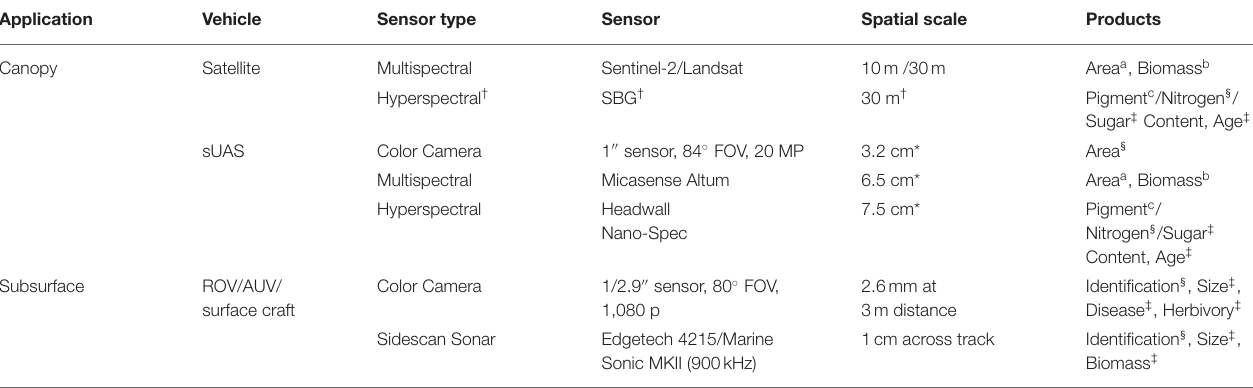
TABLE 2 | Remote sensing technologies that can be used to monitor giant kelp aquaculture farms and the products which can be derived from the imagery.